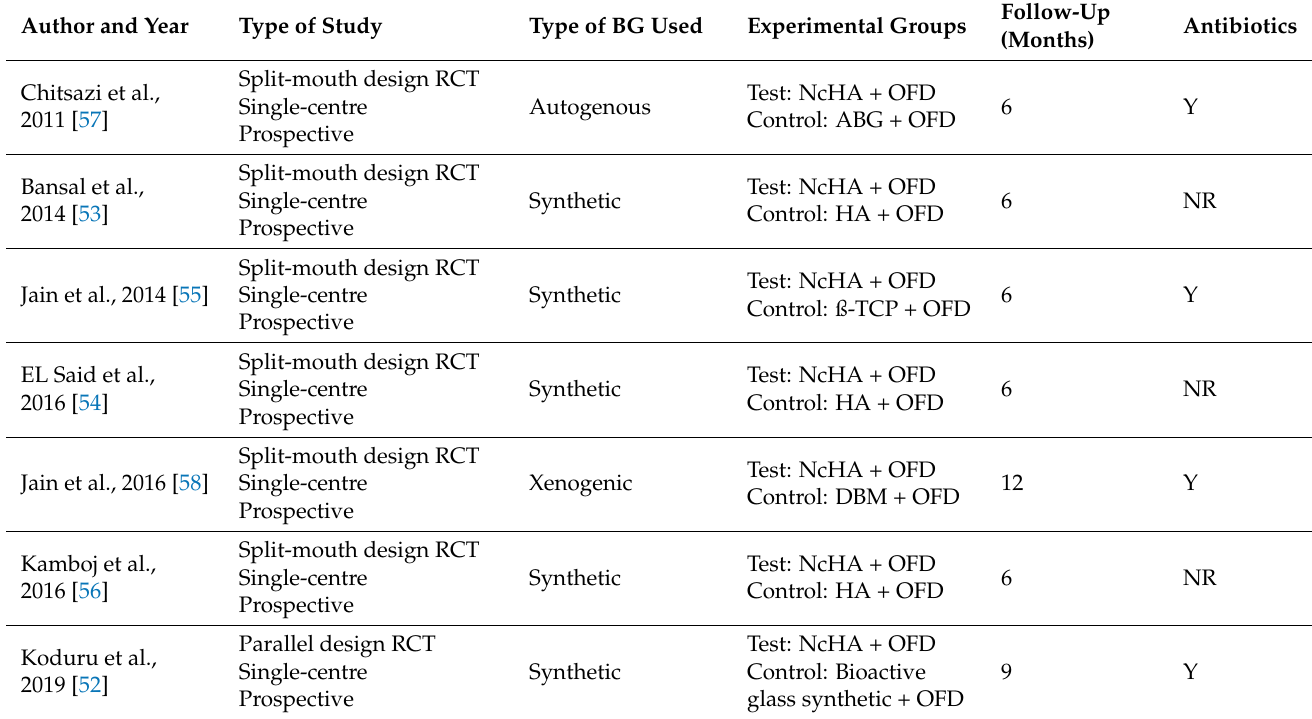
Table 2. Study characteristics.